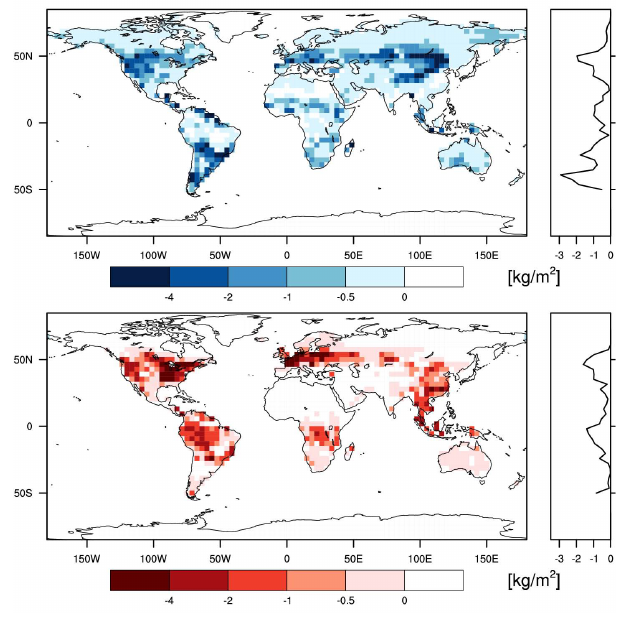
Fig. 4. The reduction in C storage (kgm − 2 ) by nutrient limitation at the end of the 21st century. Shown is the difference in the mean C storage (2070–2099) between the CN simulation and the C-only simulation (upper panel), and between the CP simulation and the C-only simulation (lower panel). The latitudinal means over land points are shown on the right